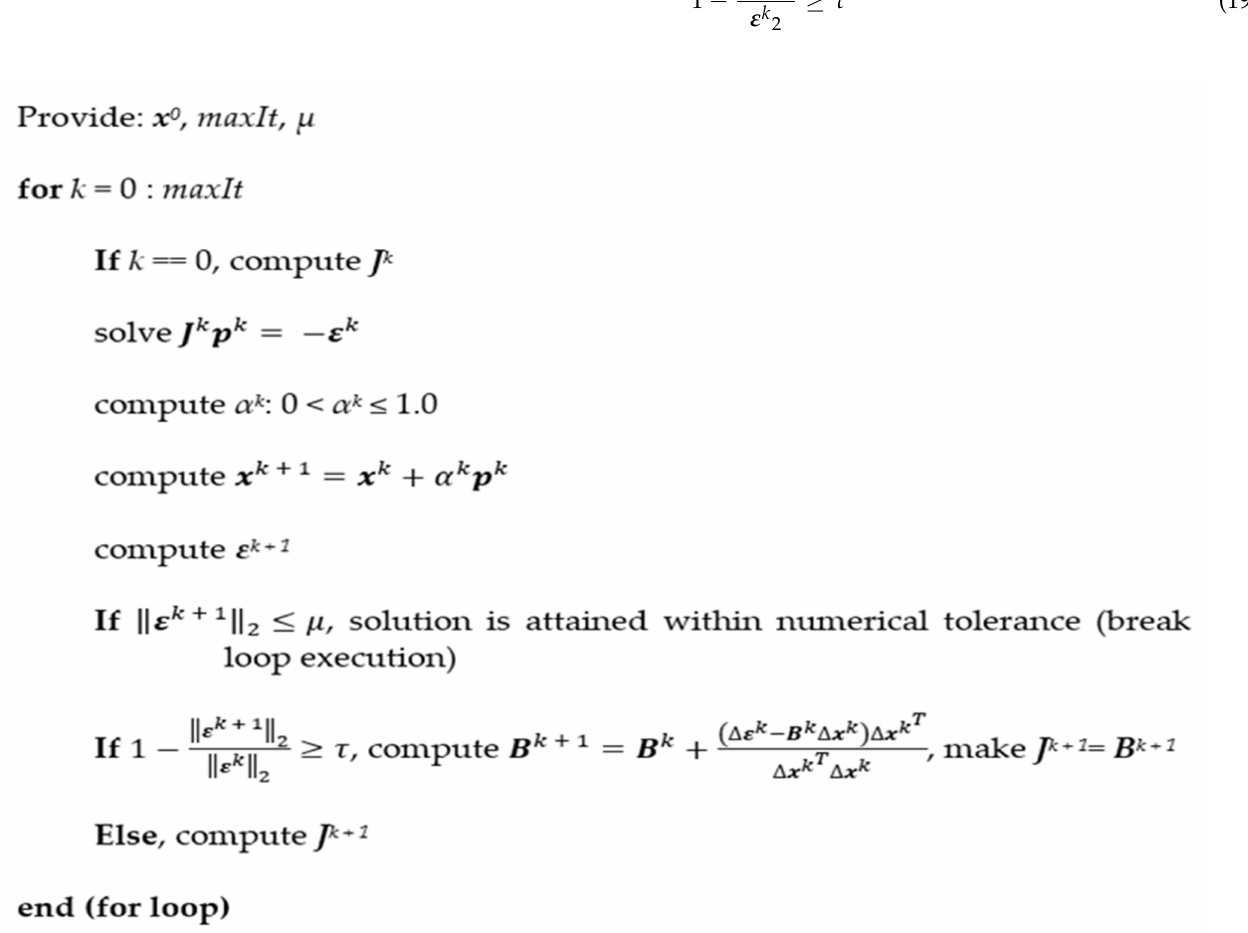
Figure 2. Quasi-Newton method iteration